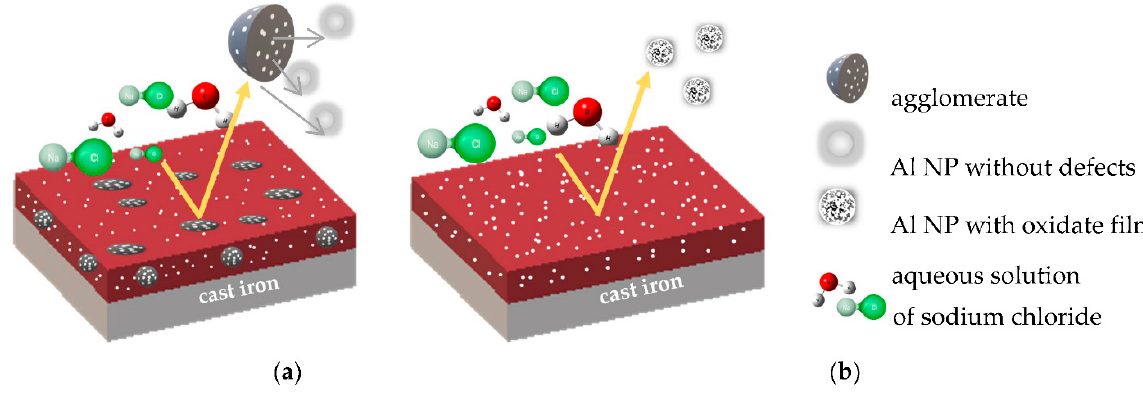
Figure 12. Graphic image of different influences of the electrolyte om the system ( a ) with agglomerates and ( b ) without agglomerates.